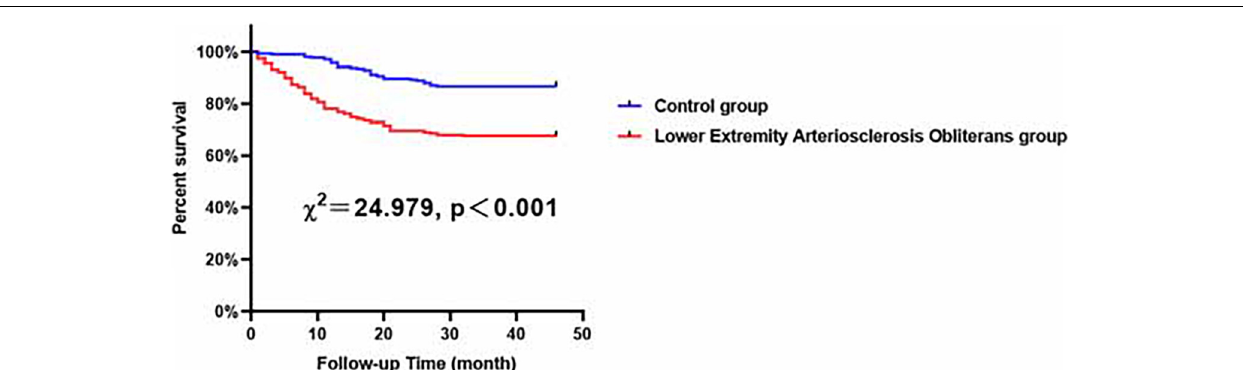
FIGURE 4 | Major adverse cardiovascular and cerebrovascular events-free survival rates for female patients with LEASO group and control group during the follow-up period.